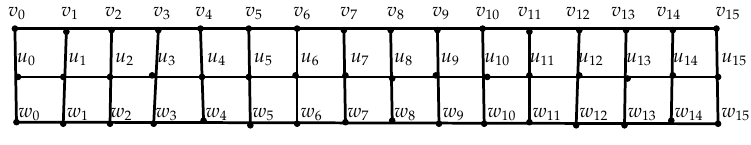
Figure 1. The grid graph P 3 (cid:3) P 16 .